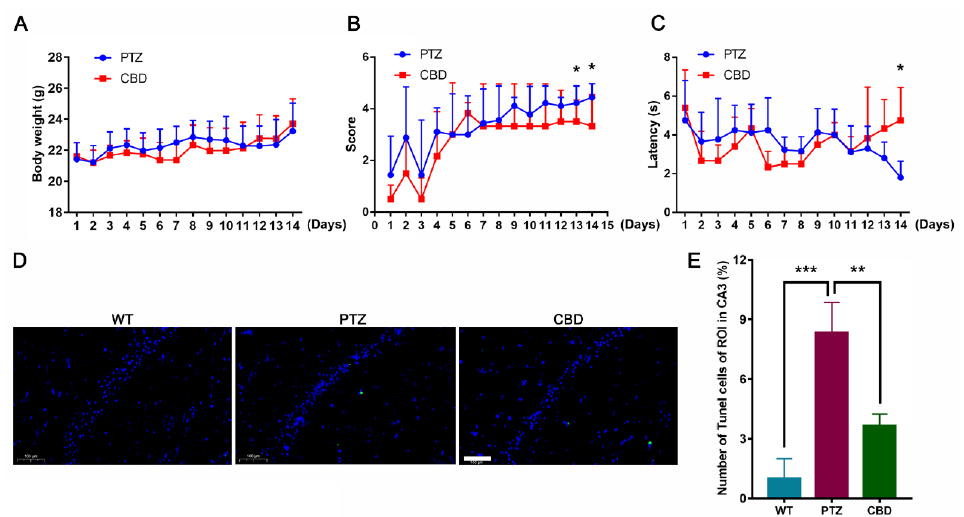
Figure 1. CBD attenuated the latency of PTZ - kindled mice. ( A ) The body weight of mice in the PTZ group and the CBD group, n = 10. ( B ) The seizure scores of mice in the PTZ group and the CBD group, n = 10. ( C ) The seizure latency of mice in the PTZ group and the CBD group, n = 10. ( D ) Representative TUNEL stained sections obtained from different groups of mice, n = 6. Scale bars = 100 µm. ( E ) Quantification of the TUNEL - positive number in hippocampus. * p < 0.05, ** p < 0.01, *** p < 0.001.